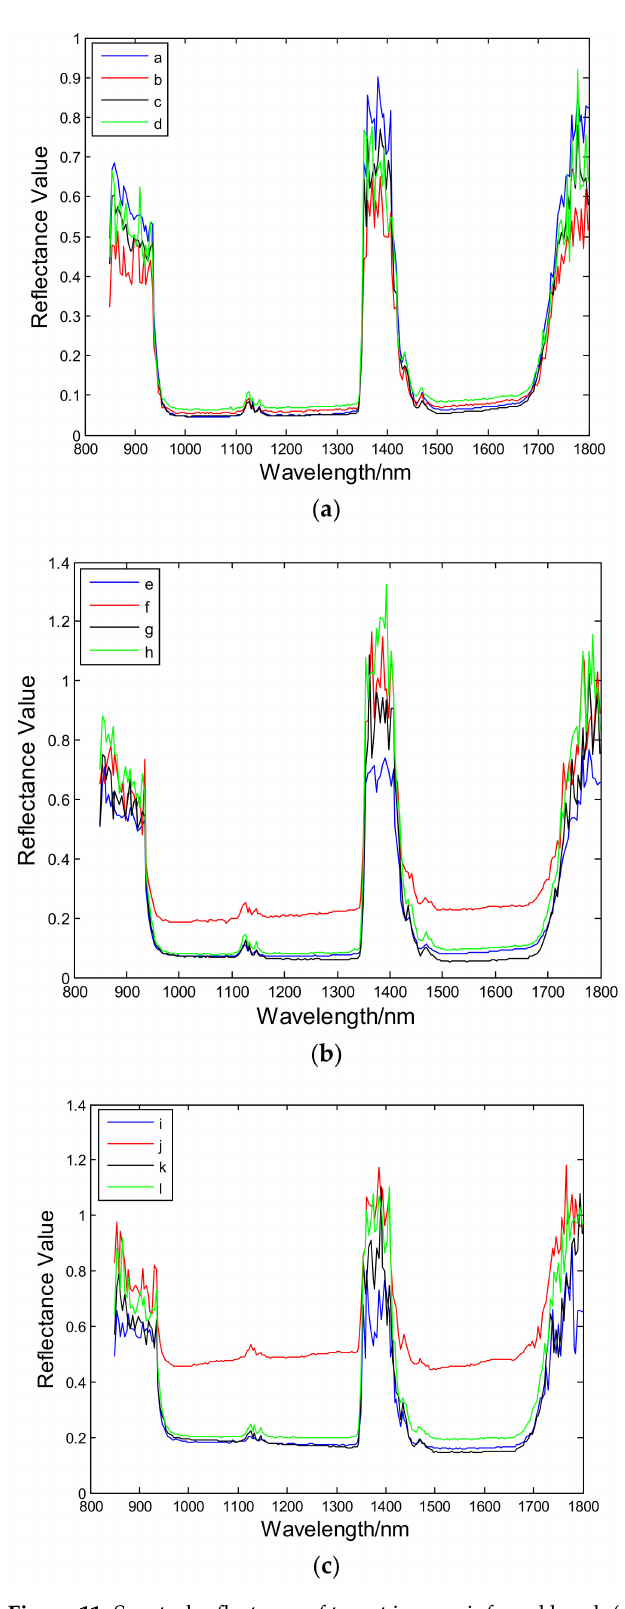
Figure 11. Spectral reflectance of target in near-infrared band. ( a ) Spectral reflectance of a–d. ( b ) Spec- tral reflectance of e–h. ( c ) Spectral reflectance of